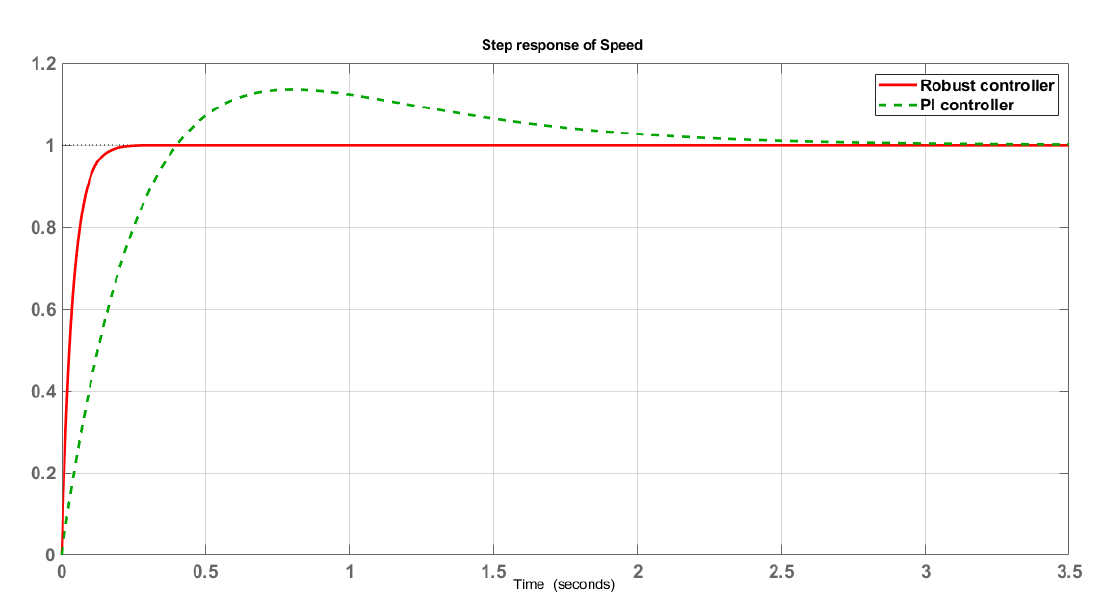
Figure 91. Speed response for two types of controllers